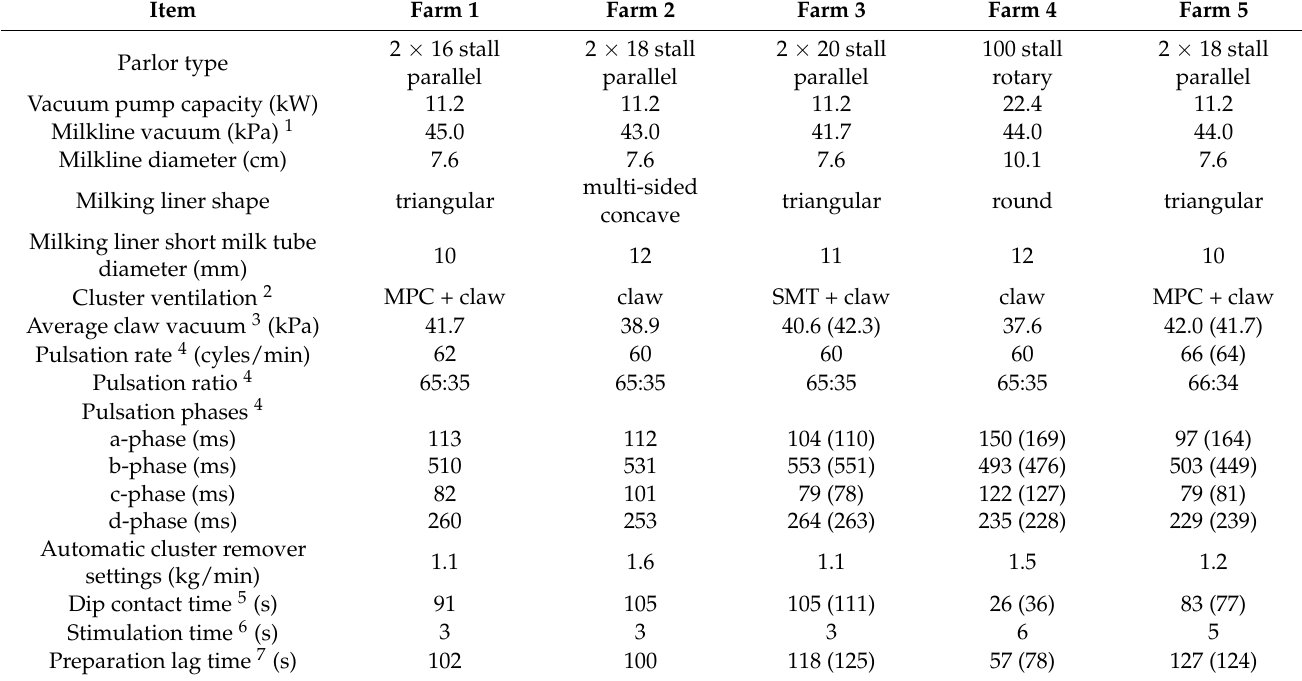
Table 1. Parlor type, milking machine equipment and settings, average claw vacuum values during the peak milk flow rate period, pulsator settings, cluster remover milk flow thresholds, and milking routine timings of 5 New York dairy farms assessed during 8 milking center evaluations. Values in parenthesis represent results from the second visit and were provided only when they deviated from those of the first